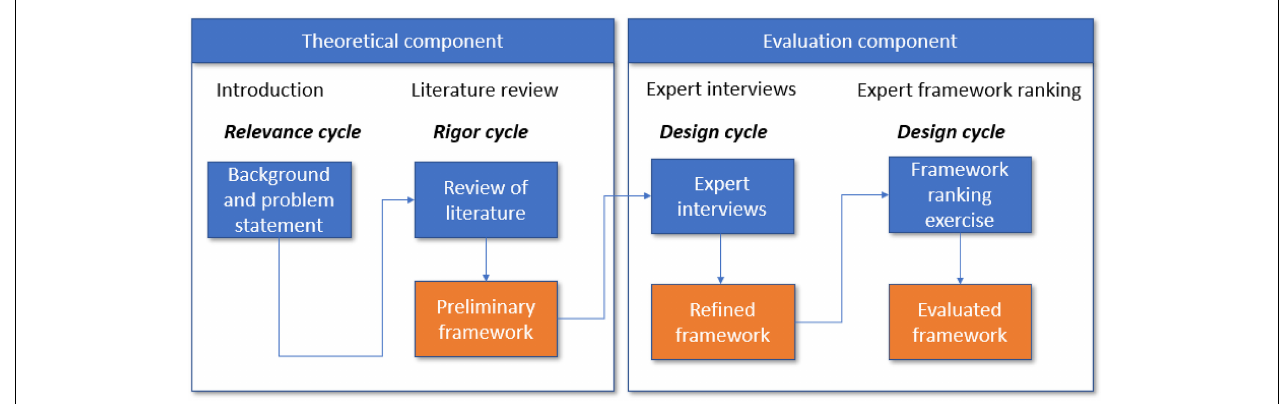
FIGURE 1 | Overview of theDSR process followed in this